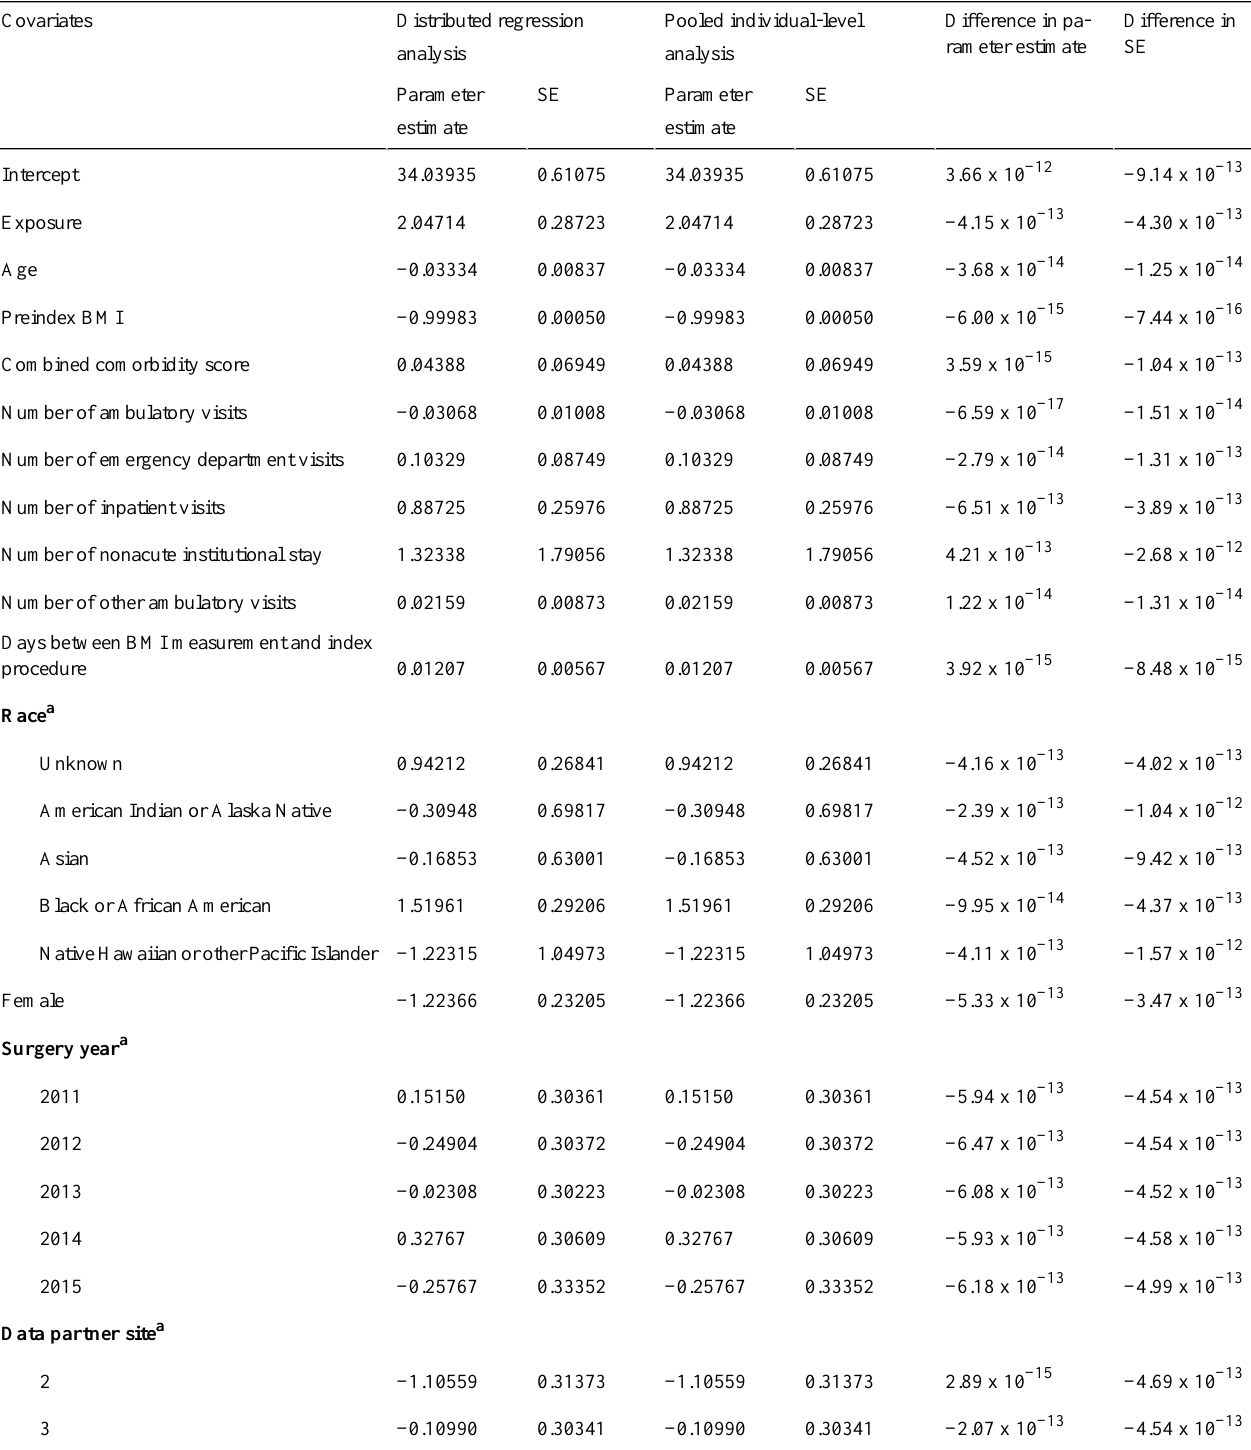
Table 2. Distributed linear regression vs pooled individual-level linear